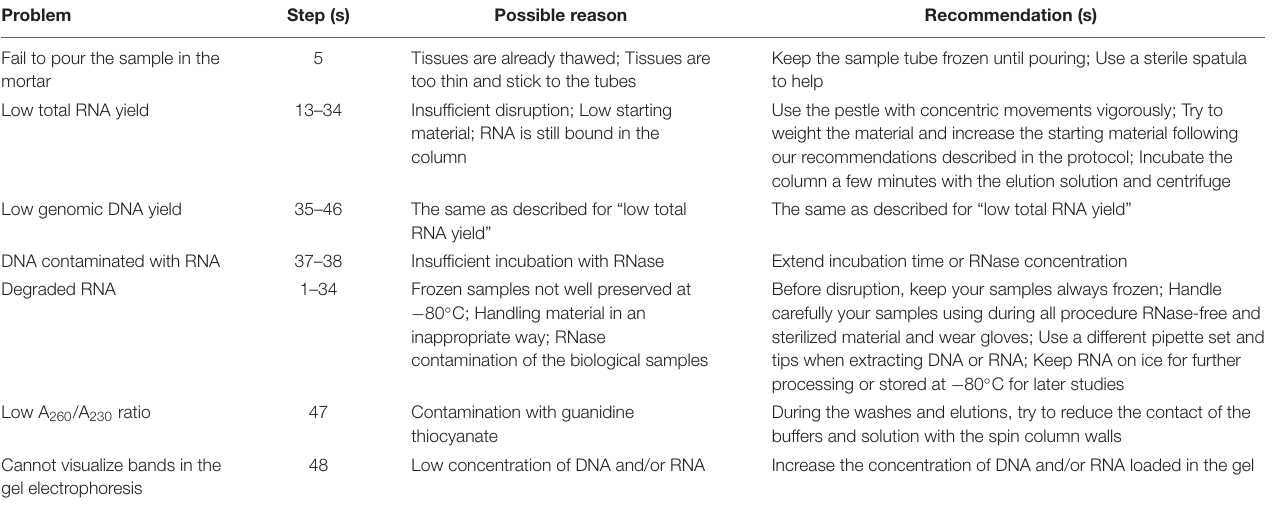
TABLE 2 | Troubleshooting: list of recommendations to overcome any artifacts or pitfalls during the whole